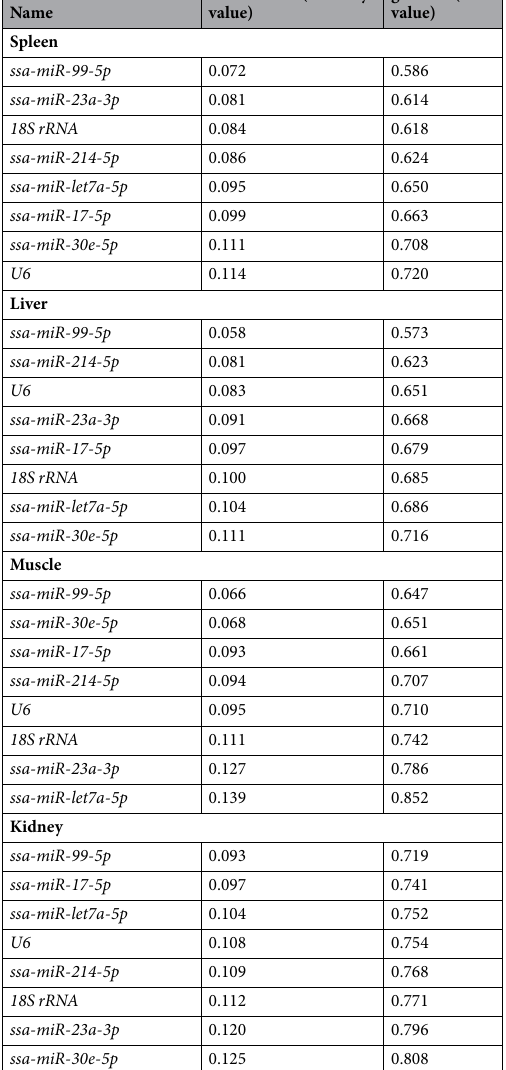
Table 5. Stability and M values for each tissue